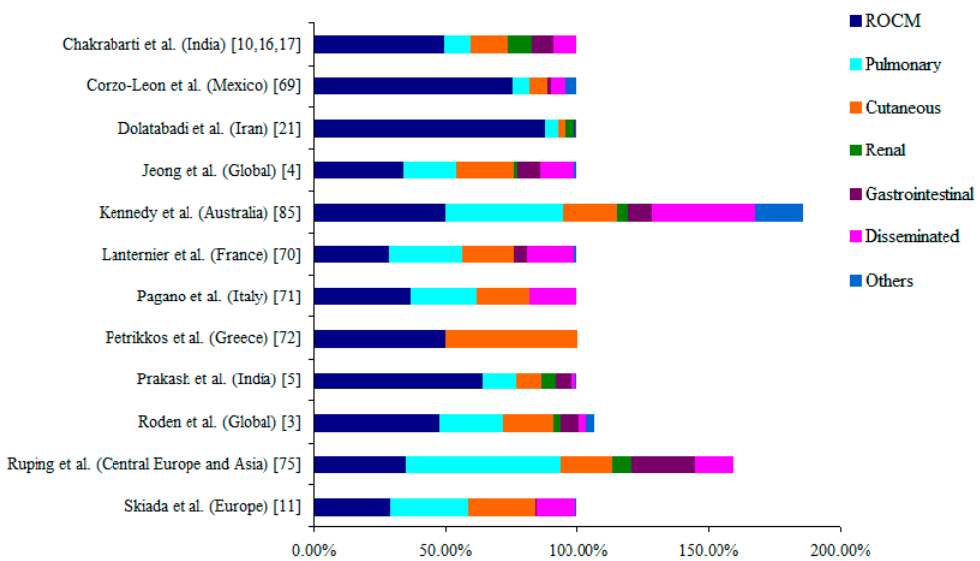
Figure 2. Clinical forms of mucormycosis reported from different studies across the globe. The percentage of values given in the figure was calculated based on the data provided in the literature. Multiple sites of infection were reported in few studies: Roden et al. 2005 [3], Ruping et al. 2010 [75], Kennedy et al. 2016 [85]. The data was pooled from studies by Chakrabarti et al. 2006, 2001, 2009 [10,16,17].